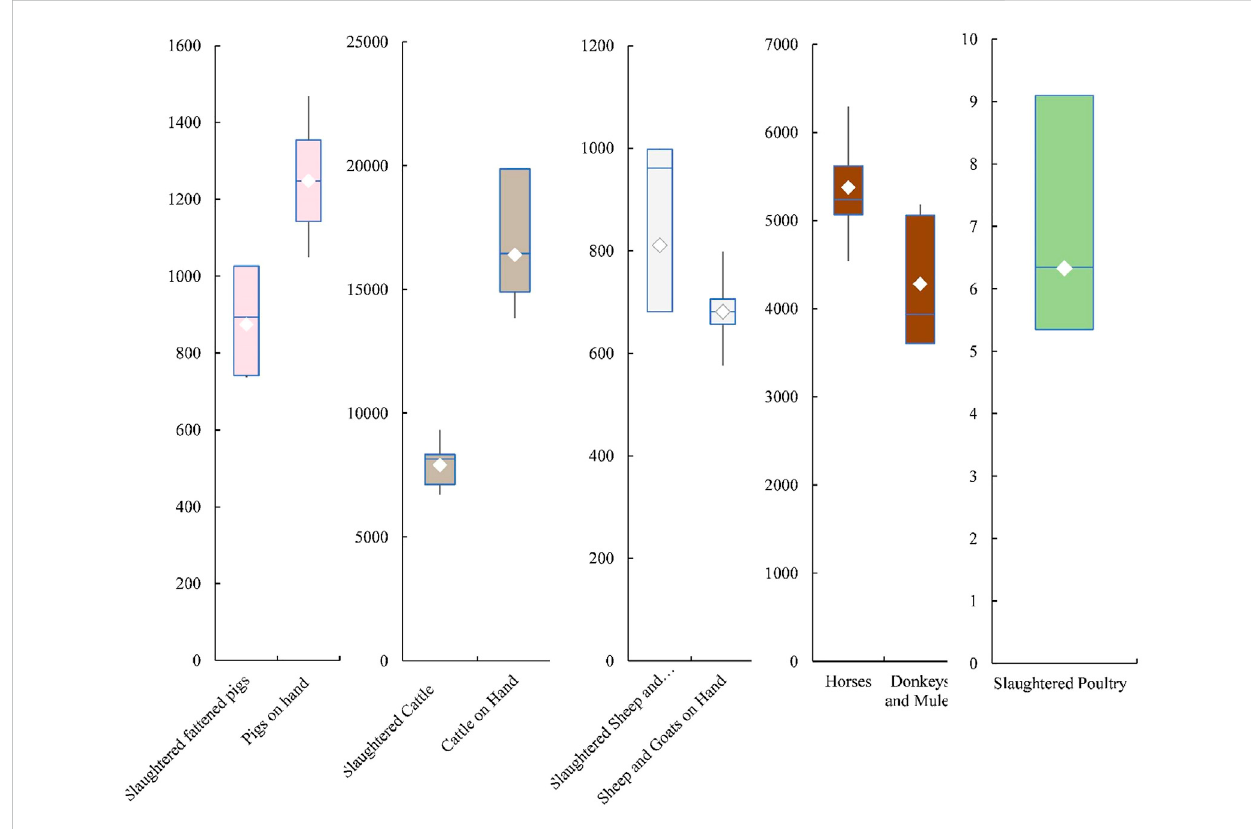
FIGURE 5 Ranges of livestock manure coef fi